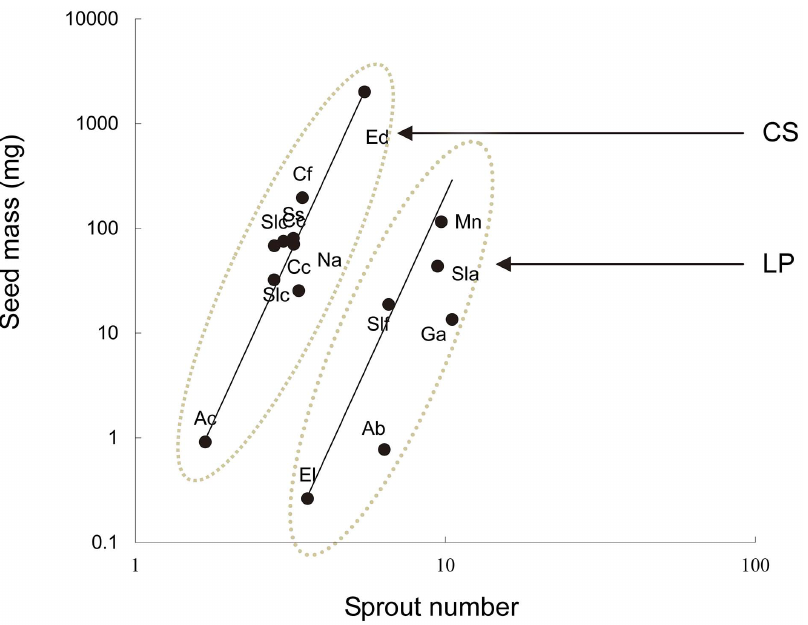
Figure 1. The relationship of seed size vs. sprouts. The bivariate relationship between seed size and trunk sprouting number among climax species (CS) and long-lived pioneers (LP) in natural habitats in a subtropical broad-leaved forest in southwestern China. The two lines in the graph denote the fitted lines to the two functional groups (slope = common slope shared by the two functional groups) using the standardised major axis (SMA); broken line, CS species group; solid line, LP group.